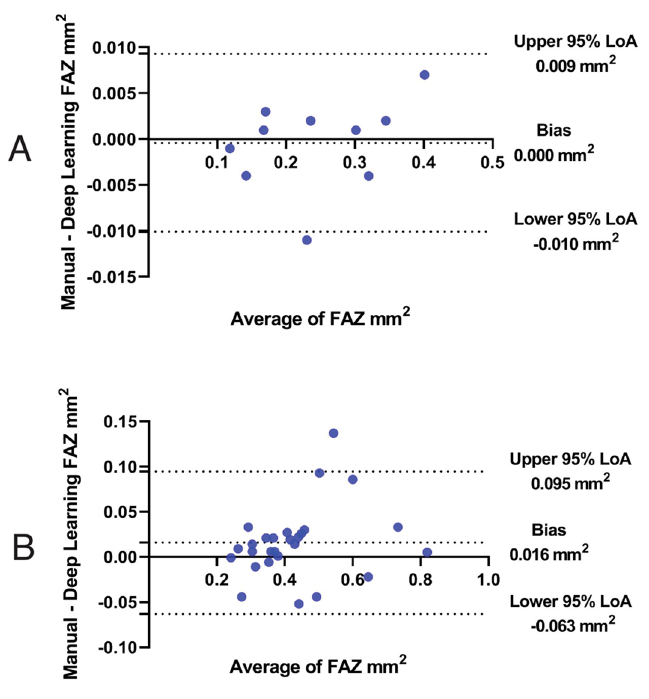
Figure 2. Bland–Altman plot demonstrates excellent agreement between manual and deep learning Foveal avascular zone (FAZ) segmentation in ( A ) normal and ( B ) eyes with diabetic retinopathy.